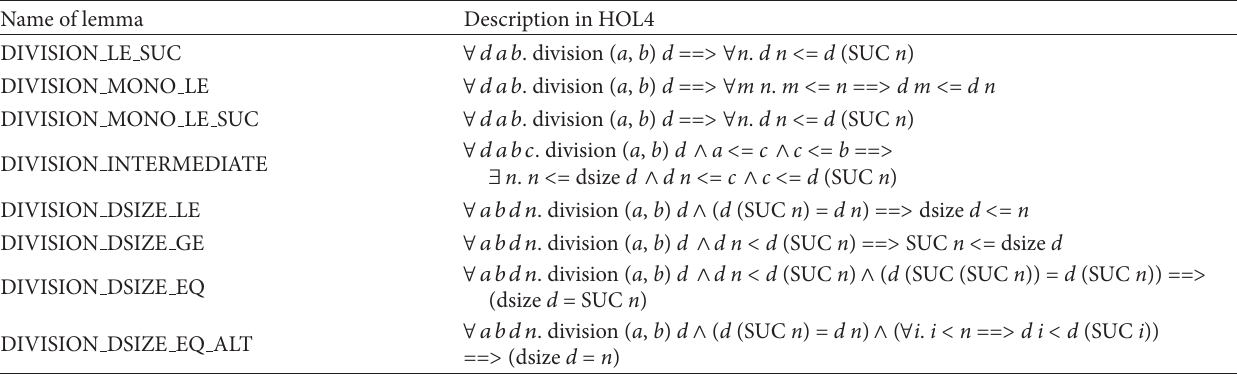
Table 2: The lemmas proving Theorem